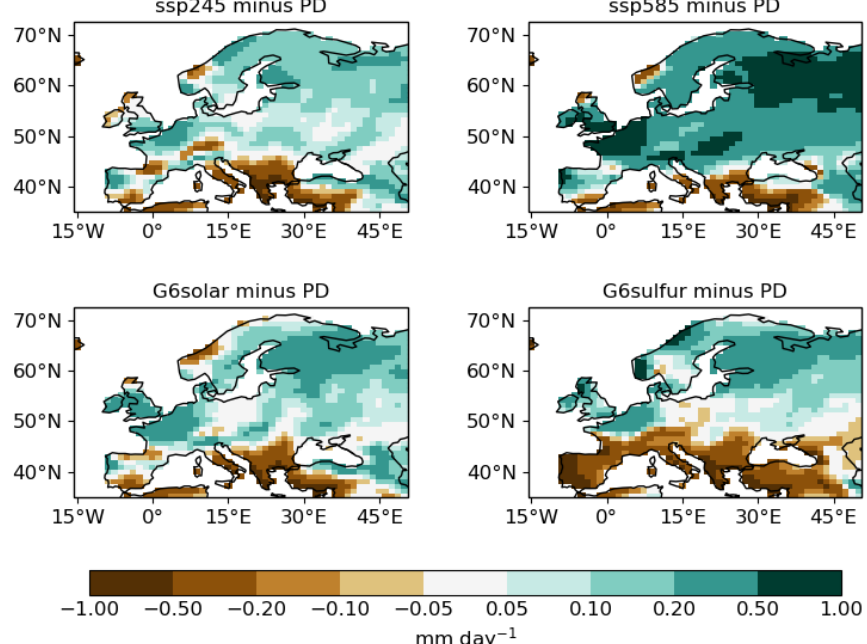
Figure 11. Same as Fig. 10 but for